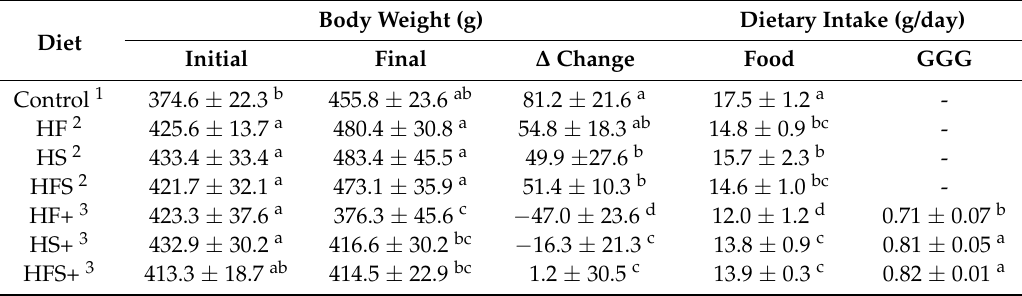
Table 2. Bioassay performance of rats fed with experimental diets (11